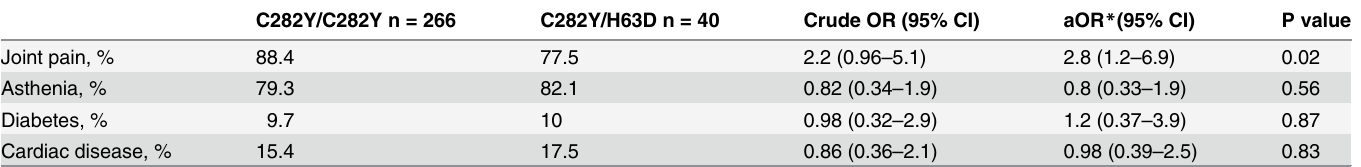
Table 2. Prevalence of self-reported symptoms at the time of the survey by genotype.